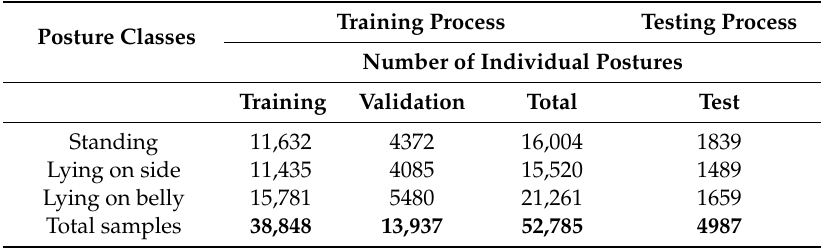
Table 1. Details of image data sets used for posture detection.